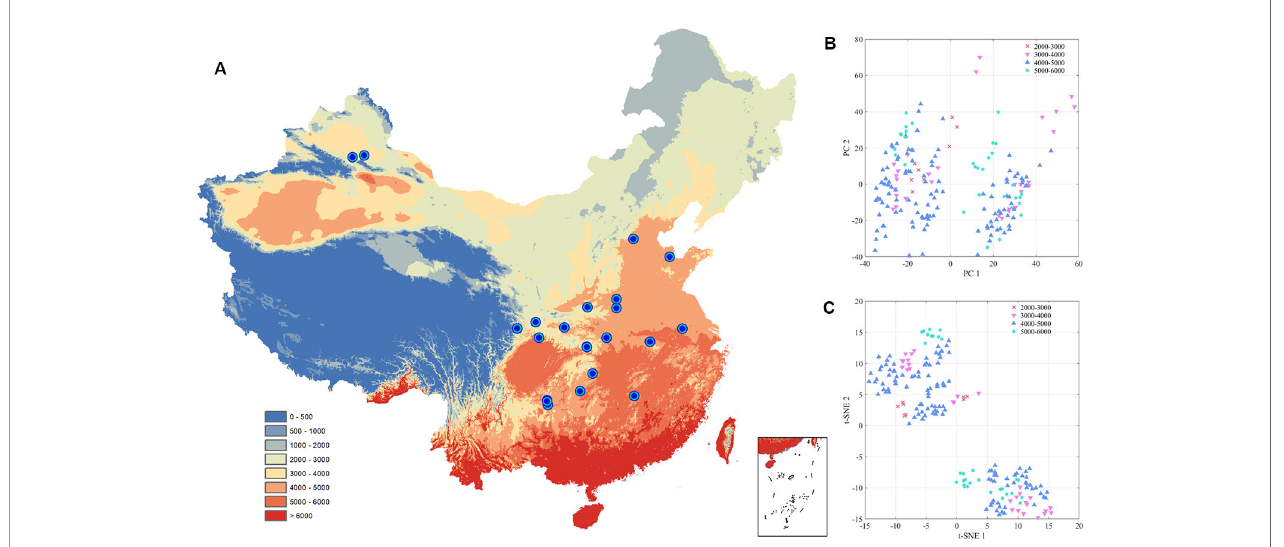
FIGURE 3 | The exploratory analysis results of Eucommia ulmoides leaves (EUL) samples in ≥ 10°C accumulated temperature (A) : The distribution of each collection site; (B) : PCA; (C) :